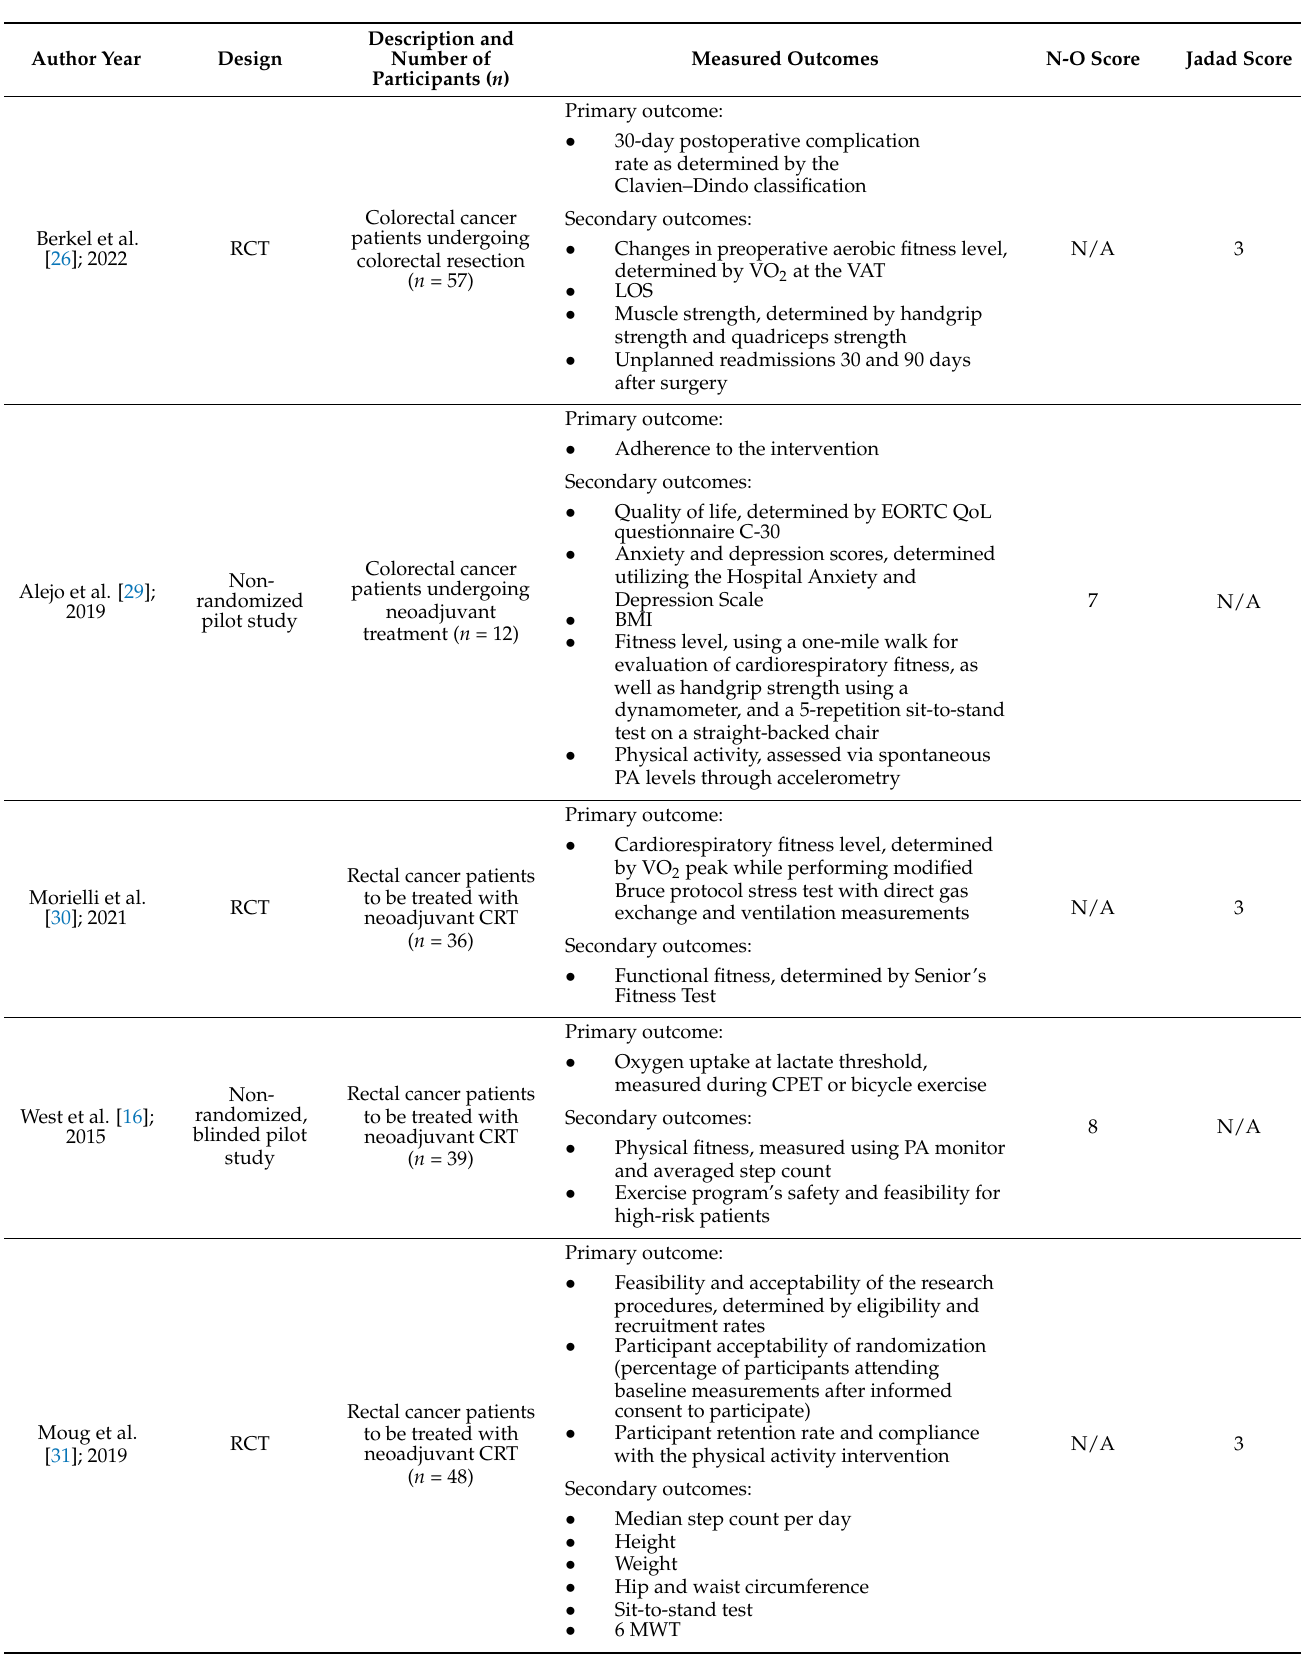
Table 2. Characteristics of prehabilitation studies of surgical management for colorectal